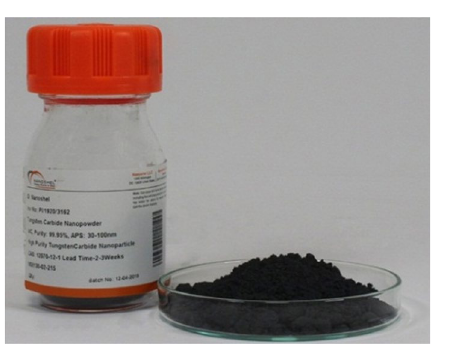
Figure 1. Nanoparticles of tungsten carbide (WC) 13